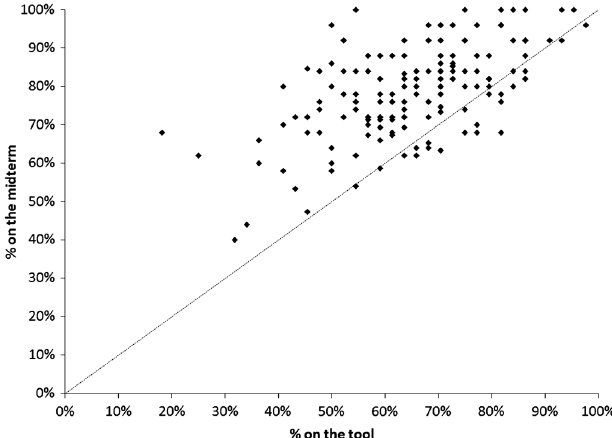
FIG. 3. There are 160 students who answered all problems in the tool. Each diamond represents a student’s score on the exam- prep tool and the exam. The horizontal axis is the students’ scores on the practice problems. The vertical axis represents the students’ scores on the exam. Most points lie above the dashed line, showing students performed better on the exam than on the exam-prep